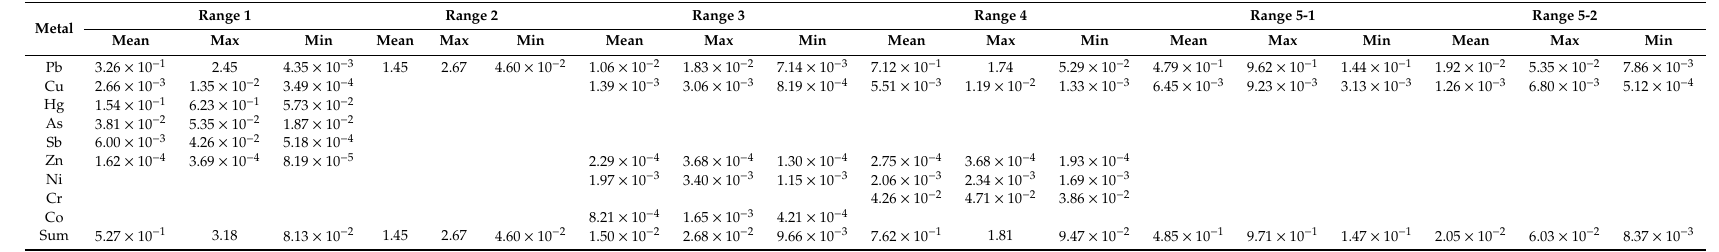
Table 3. Non-carcinogenic risks (HI) of heavy metals in shooting range